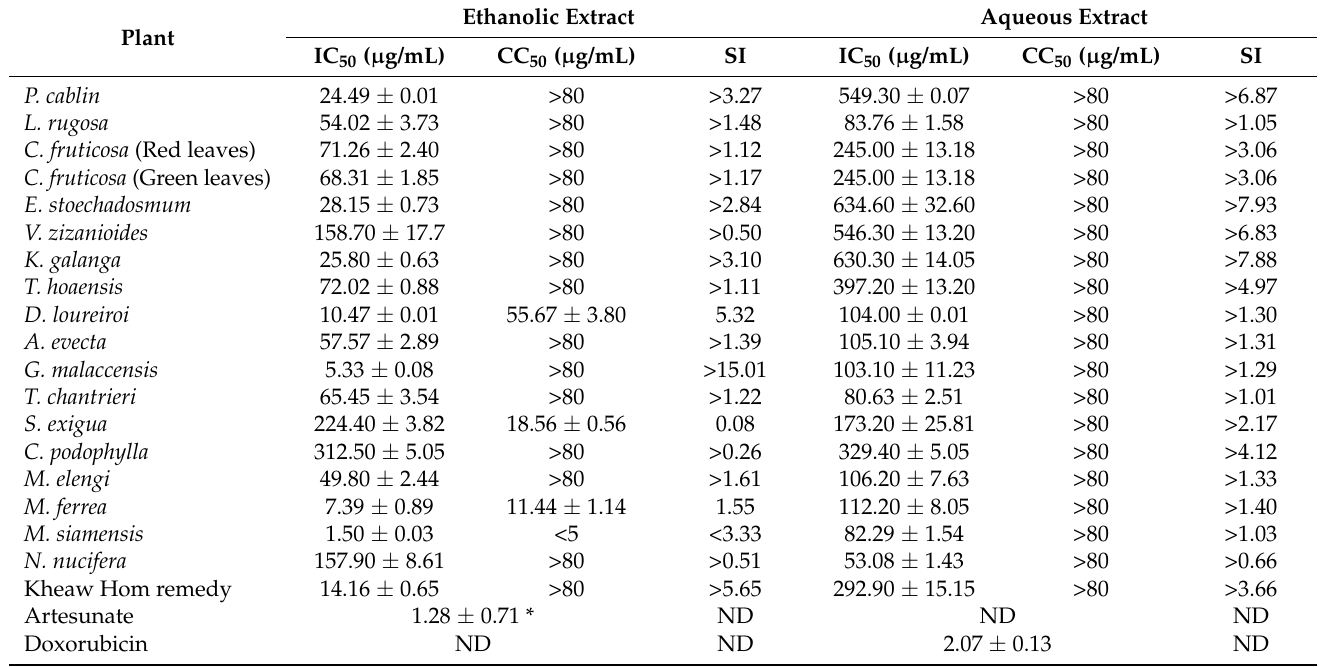
Table 4. In vitro antimalarial activity and cytotoxicity of the crude extracts from the Kheaw Hom